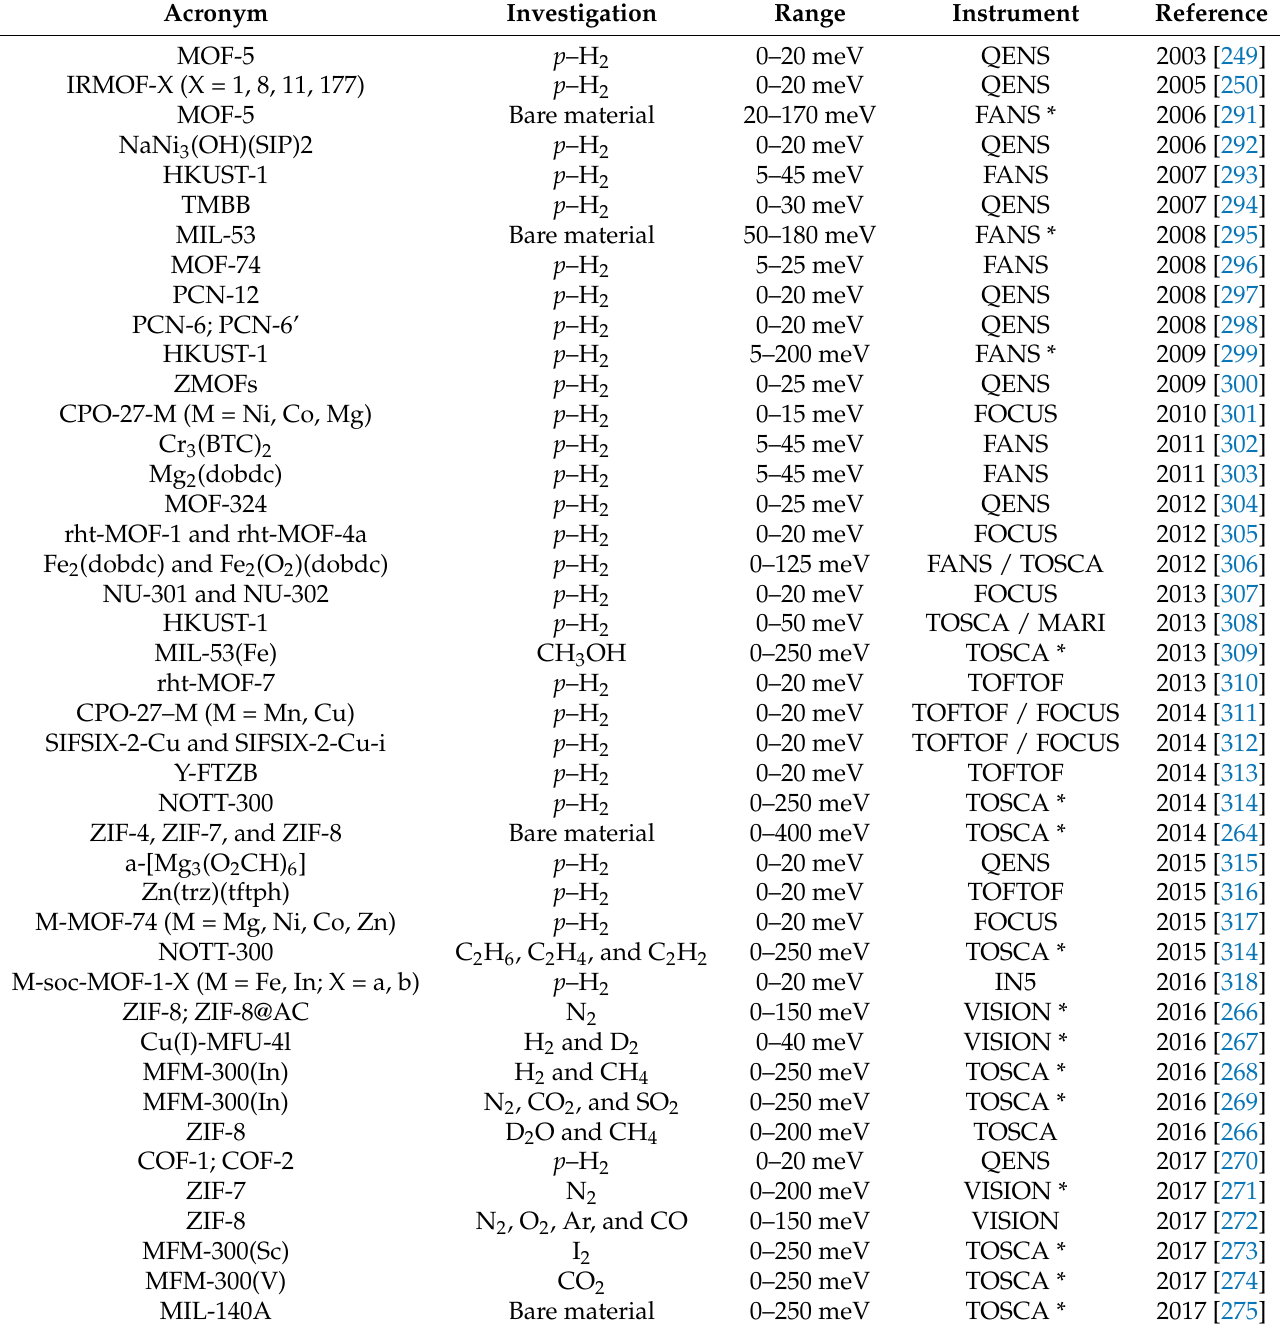
Table 1. Summary of INS studies on MOFs and COFs. The first column indicates the acronym of the material, as commonly used in the literature. The second column indicates whether the focus of the investigation was on the bare material or on the uptake of the chemical species shown. The third and fourth columns show the energy-transfer range and INS spectrometer used (QENS, IPNS; FANS, NIST; FOCUS, SINQ; TOSCA and MARI, ISIS; TOFTOF, MLZ; IN5, ILL; VISION and SEQUOIA, SNS). Asterisks on the latter column indicate that solid-state DFT was used to interpret the INS data. Works are presented in chronological order, with the year of publication given along with its bibliographic reference in the last